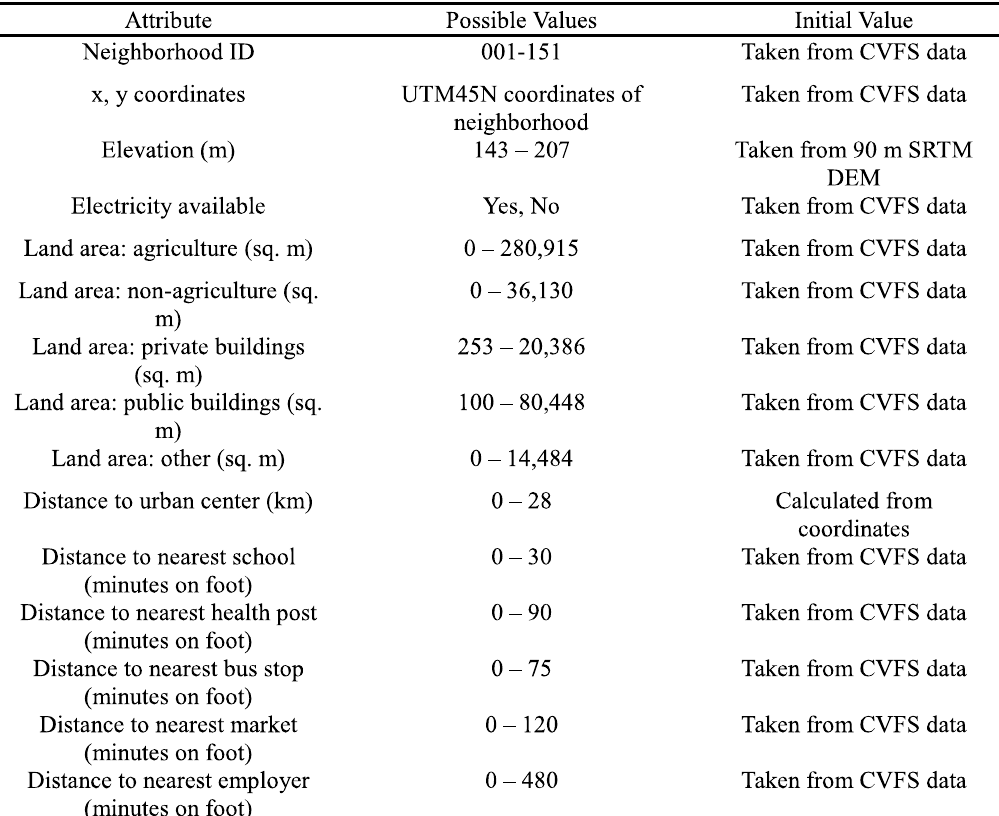
Table A1.3: Attributes of the 'neighborhood' agent